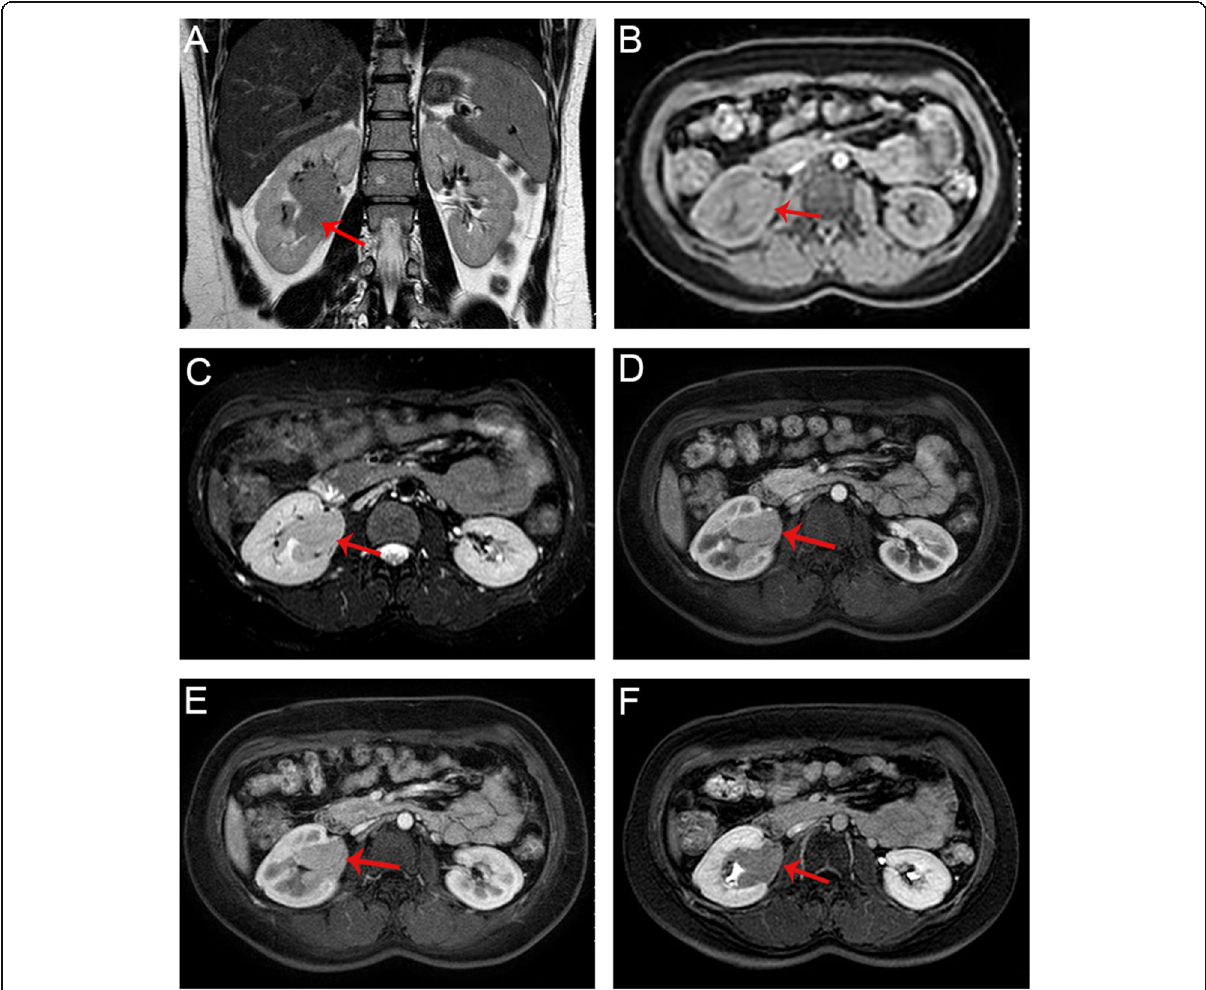
Fig. 1 Contrast-enhanced abdominal MRI of the lesion (red arrow) in case 1. (A) Coronal T2-weighted image; (B) Transverse T1-weighted with fat suppression (C) Transverse T2-weighted with fat-suppression; (D) Transverse T1-weighted with fat-suppression in arterial phase; (E) Transverse T1- weighted with fat-suppression in portal phase; (F) Transverse T1-weighted with fat-suppression in delayed